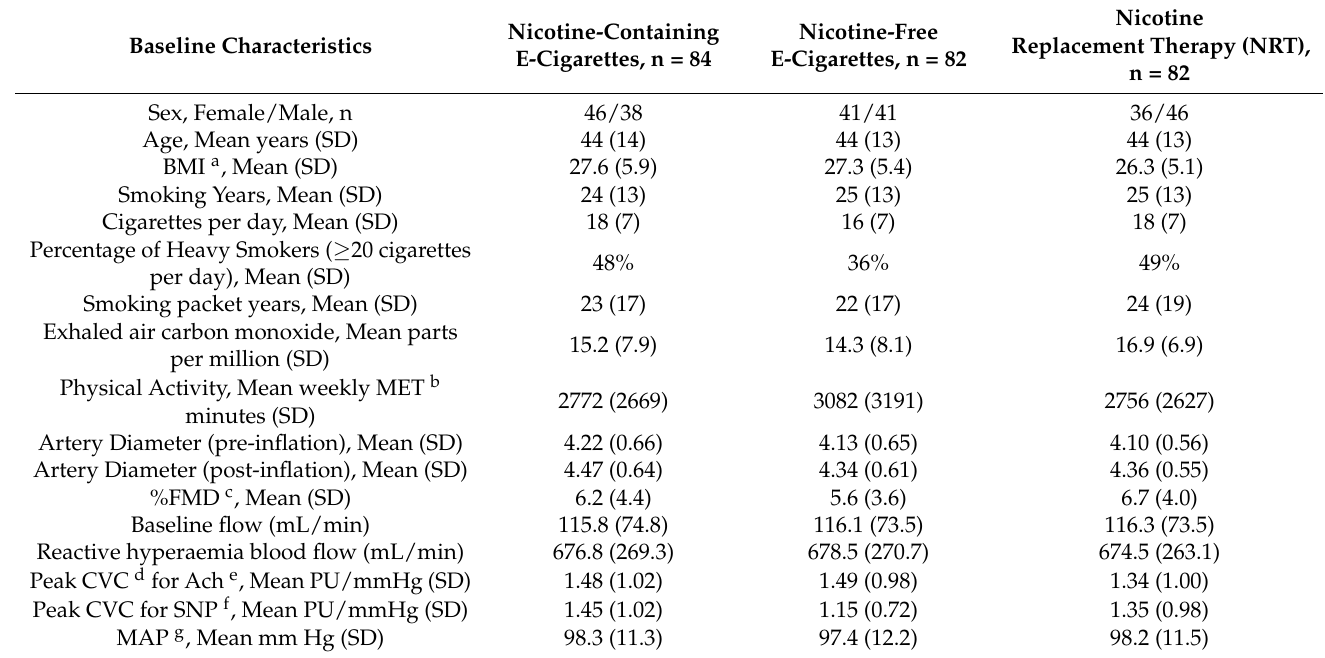
Table 1. Sample description, n =